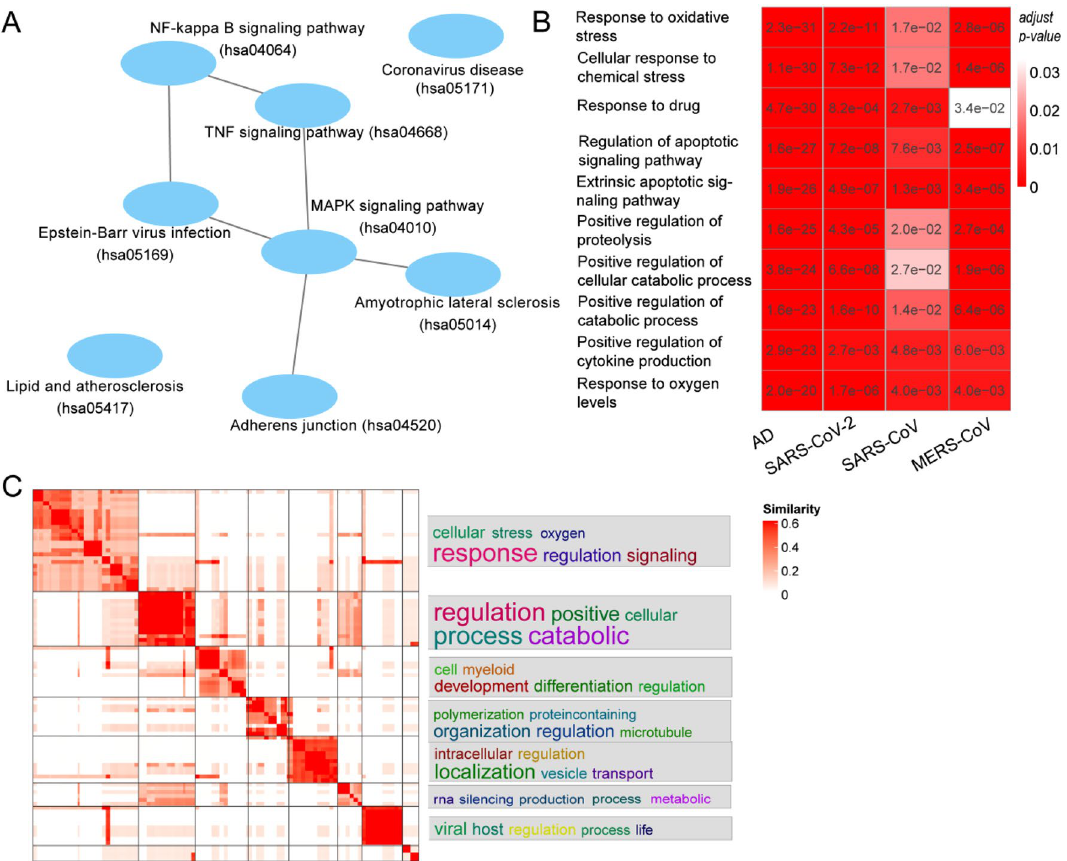
Figure 3. The shared KEGG pathways and biological processes between coronavirus infection and AD. ( A ) The shared KEGG pathways between coronavirus infection and AD 25 . ( B ) Top ten most enriched GO terms in the domain of Biological Processes. The GO terms were sorted by the adjusted p-value of GO terms obtained in AD. The heat map was colored based on the adjusted p-value (shown in the heat map) according to the legend in the top right. ( C ) Clustering of the shared GO terms in the domain of Biological Process between coronavirus infection and AD. The heat map was colored based on the pairwise similarity of GO terms according to the figure legend in the top right. The words in the right side of the figure referred to top five words which appeared most frequently in the GO terms of the corresponding cluster that were shown in the heat map. The size of words was in proportion to the frequency of them in GO terms of the corresponding cluster.